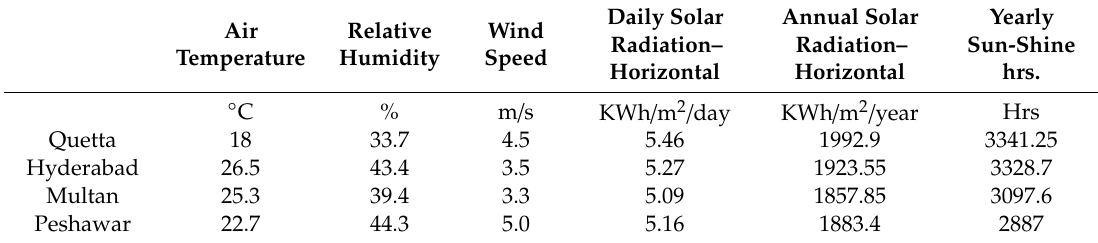
Table 3. The average meteorological conditions of the proposed locations.